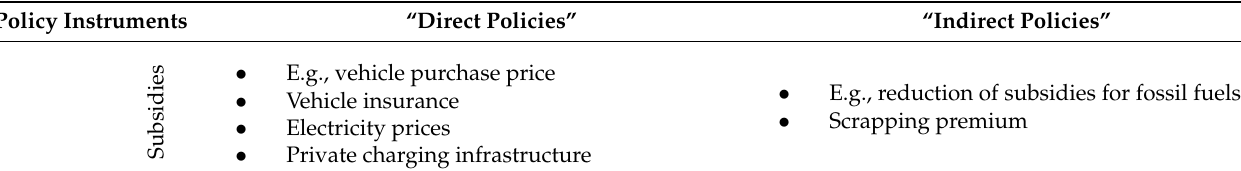
Table 2. Policy instruments to promote E-Mobility